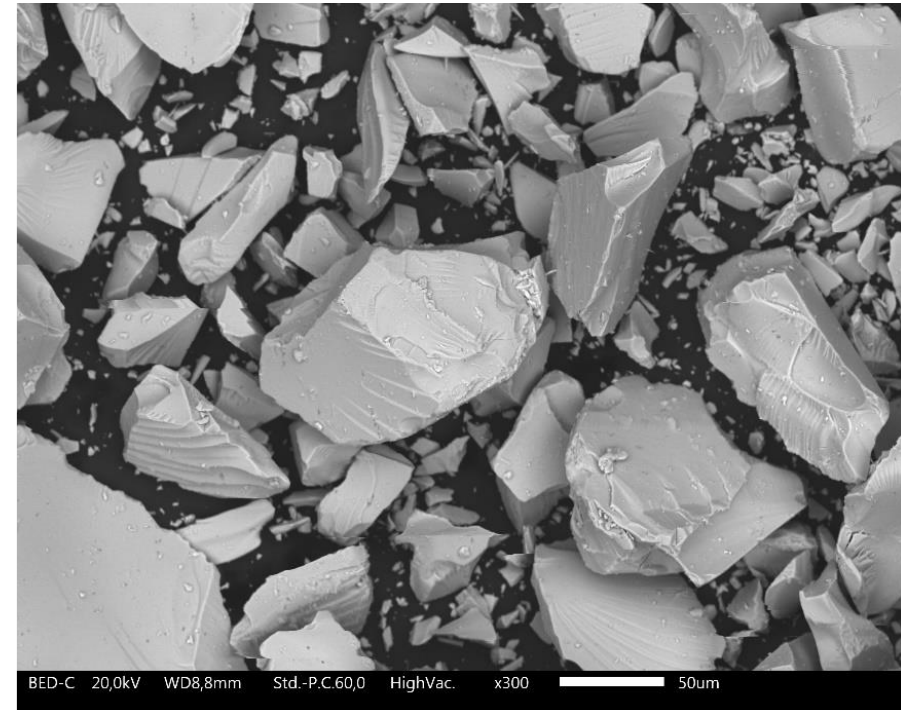
Figure 2. Colloidal silver acquired by SEM.